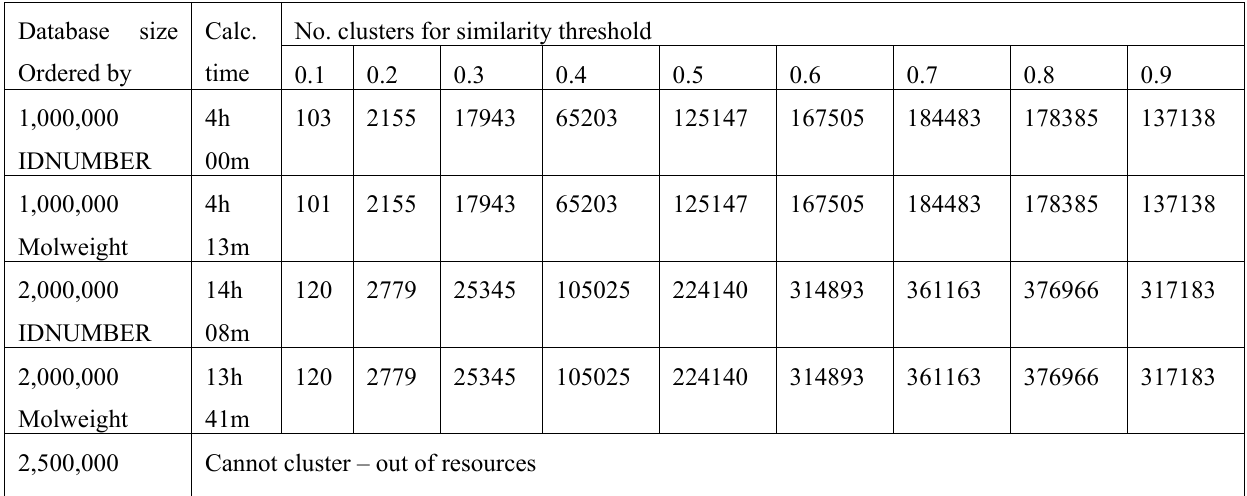
Table 1. The result of clustering for databases of different size ( Nst =10, Minimal Cluster Size=2) and sorted by different